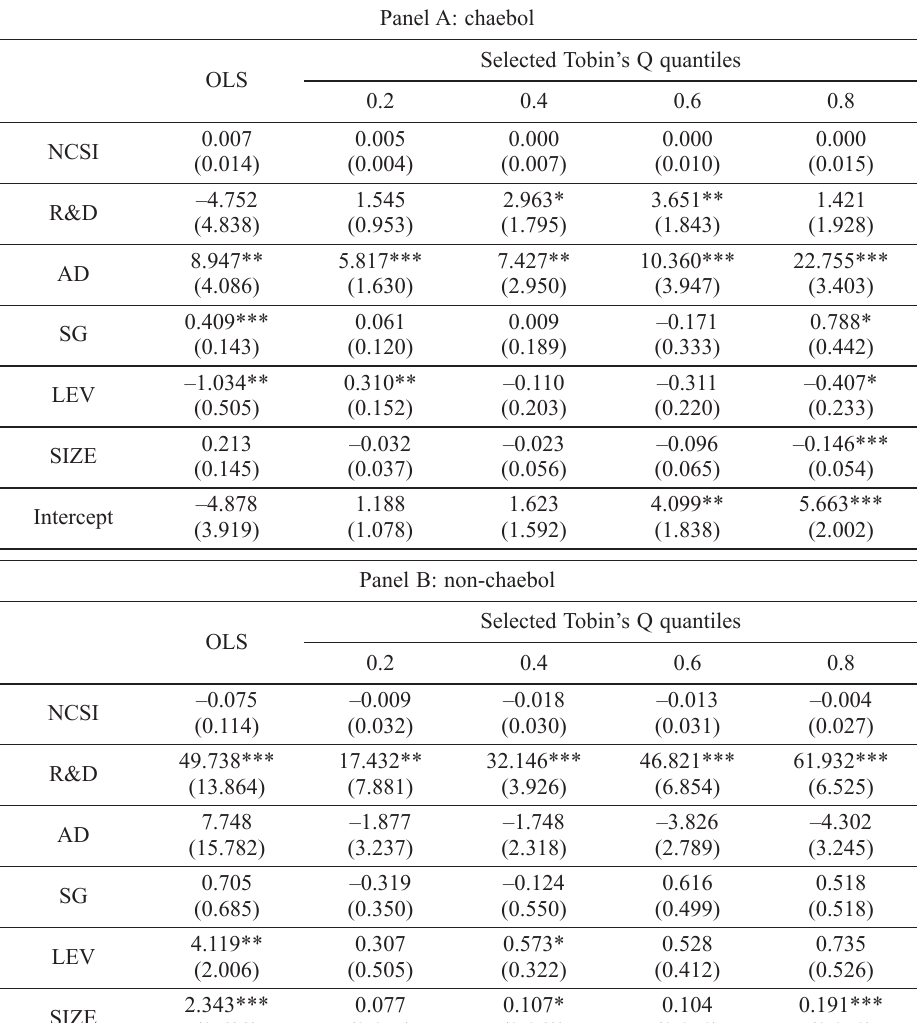
Table 3. The effects of customer satisfaction on firm value: chaebol vs